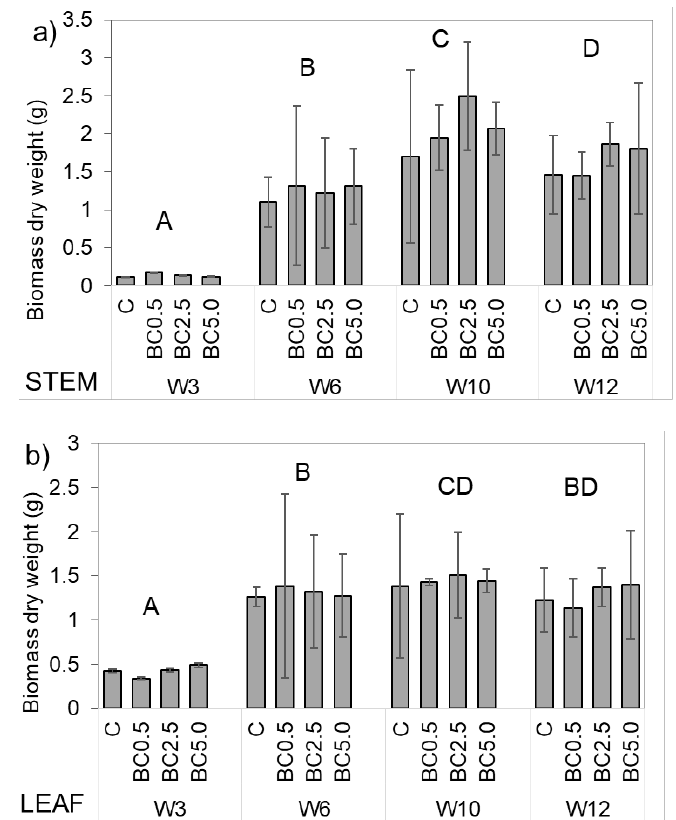
Figure 3. Plant biomass values based on Capsicum annuum ( a ) stems and ( b ) leaves collected at the different phenological phases. Measurements are on a dry mass basis per plant. Capital letters represent statistical differences of p < 0.05 among growth stages. n = 3 to 12, ±SD.